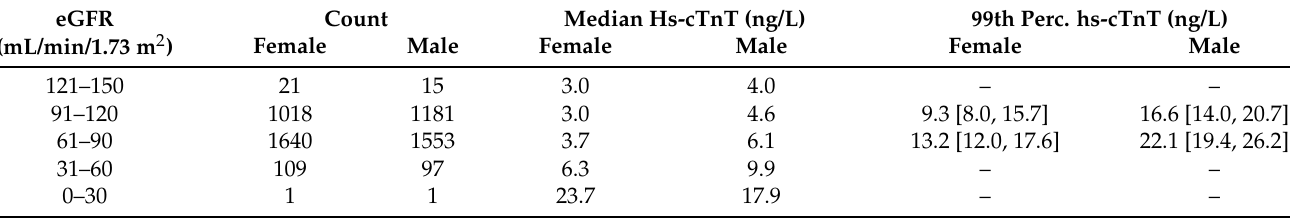
Table 4. Median and 99th percentile hs-cTnT values in relation to renal function measured by eGFR and number of participants per group separated by sex, respectively, in study cohort 2. eGFR values are binned in increments of 30 mL/min/1.73 m 2 . The 99th percentiles and their 95% confidence intervals were given in groups with at least 300 subjects. Median hs-cTnT values increase with falling eGFR. Hs-cTnT: highly sensitive cardiac troponin T; eGFR: estimated glomerular filtration rate.